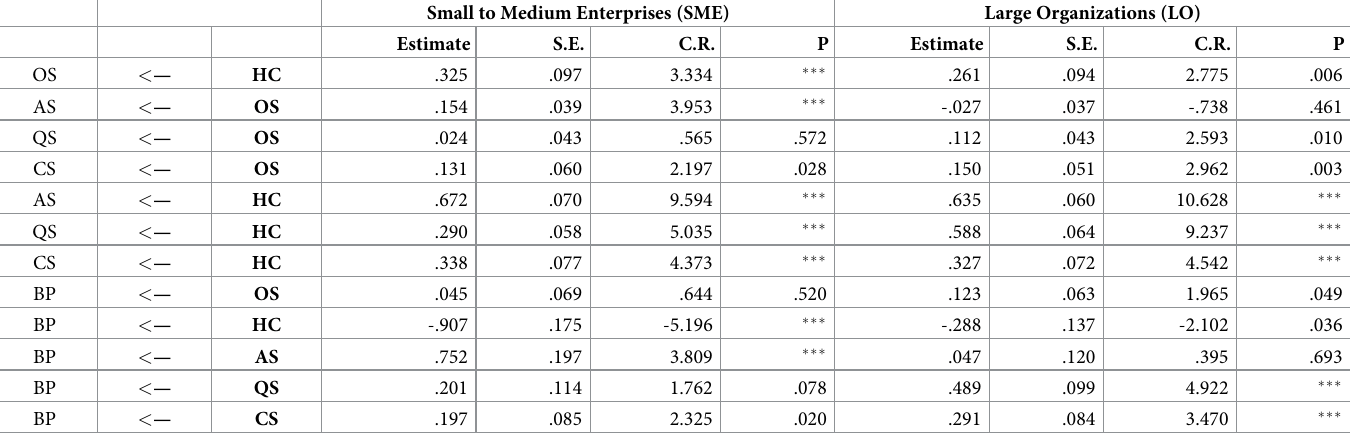
Table 5. Regression weights.